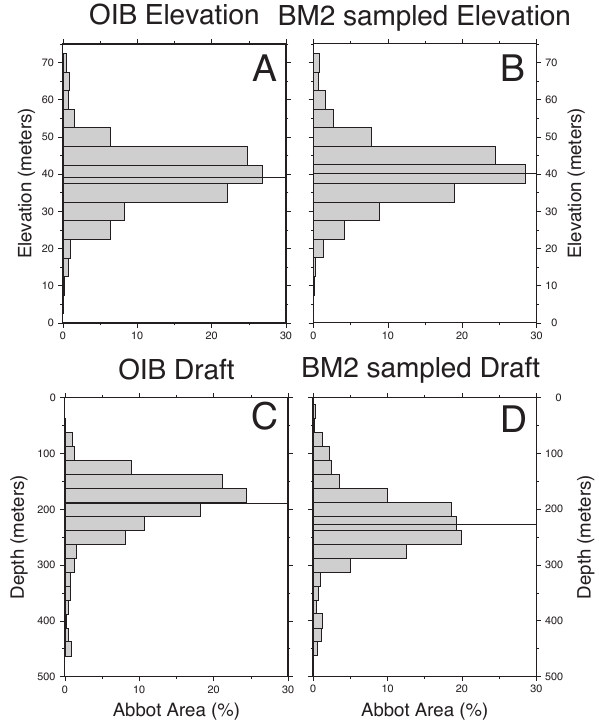
Fig. 7. Distribution of Abbot Ice Shelf surface elevations and drafts below the sea surface. (A) Surface ice elevation from OIB altimeter data at 0.2km intervals along flight lines. (B) Surface ice elevation from Bedmap2 surface elevation grid sampled at the same locations as the OIB elevation data. (C) Draft from OIB altimeter and radar data at 0.2km intervals along flight lines. (D) Draft from the grid of Bedmap2 drafts sampled at the same locations as the OIB draft data. Horizontal lines show the mean values for each set of mea-